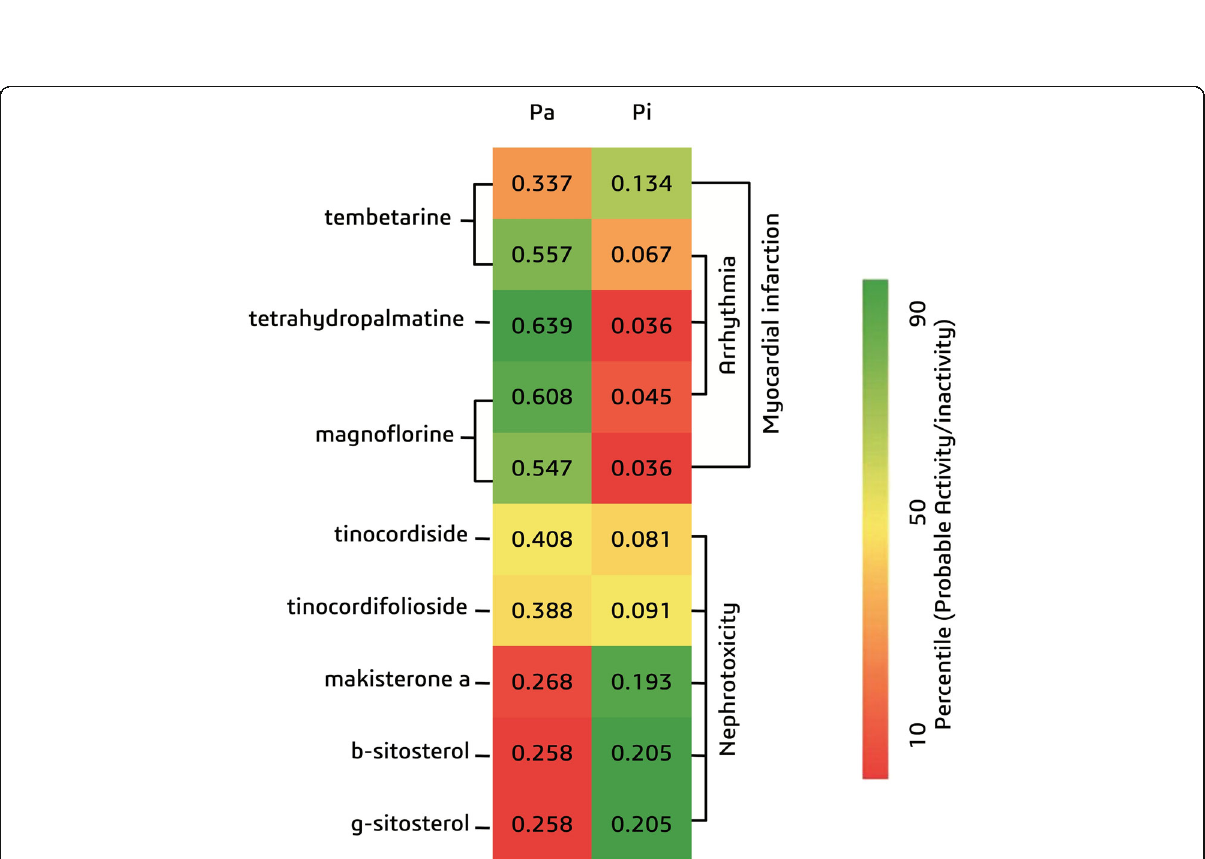
Fig. 2 Probable side effects of phytoconstituents. Pa: Probable activity, Pi: Probable